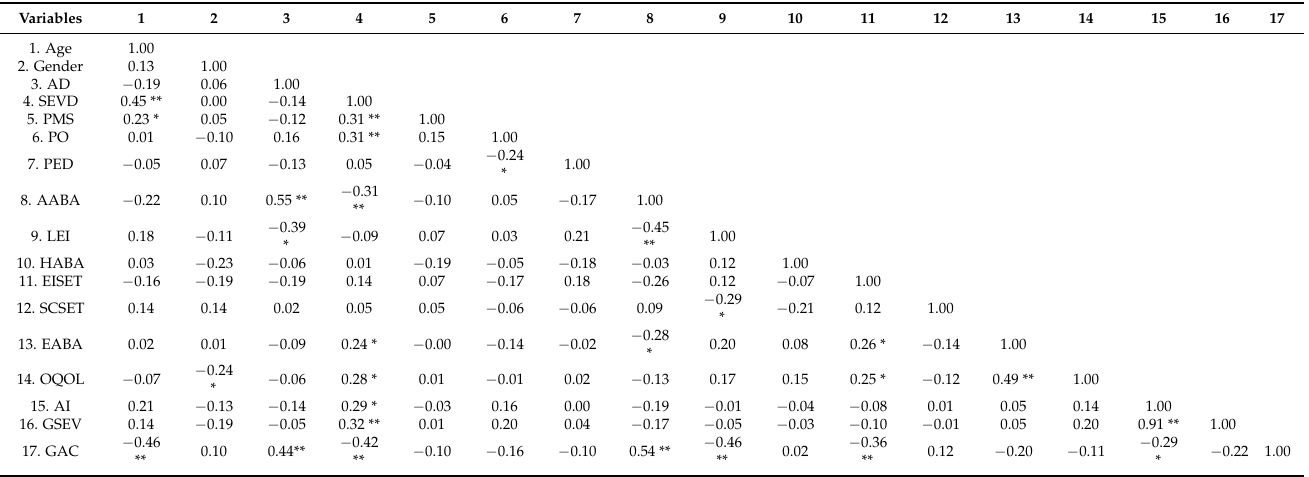
Table 4. Parent Report of Early Intervention Variables: